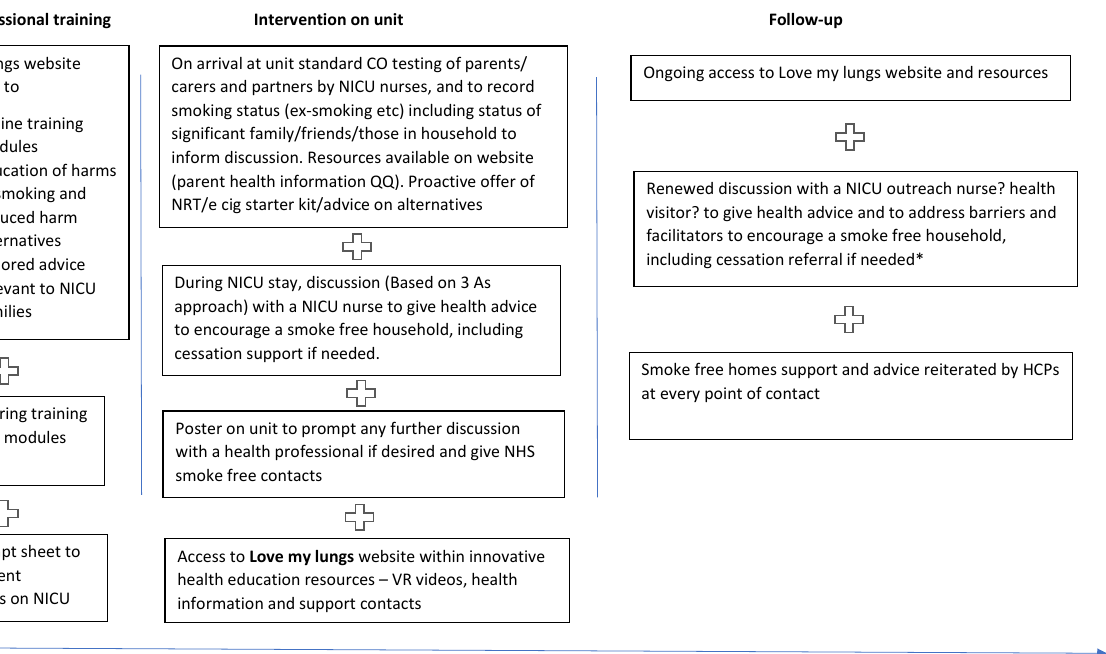
Figure 2: Final Intervention Pathway ‘Love my lungs’ Whole family and smoke free home approach – from baby perspective Health professional training Intervention on unit Follow-up